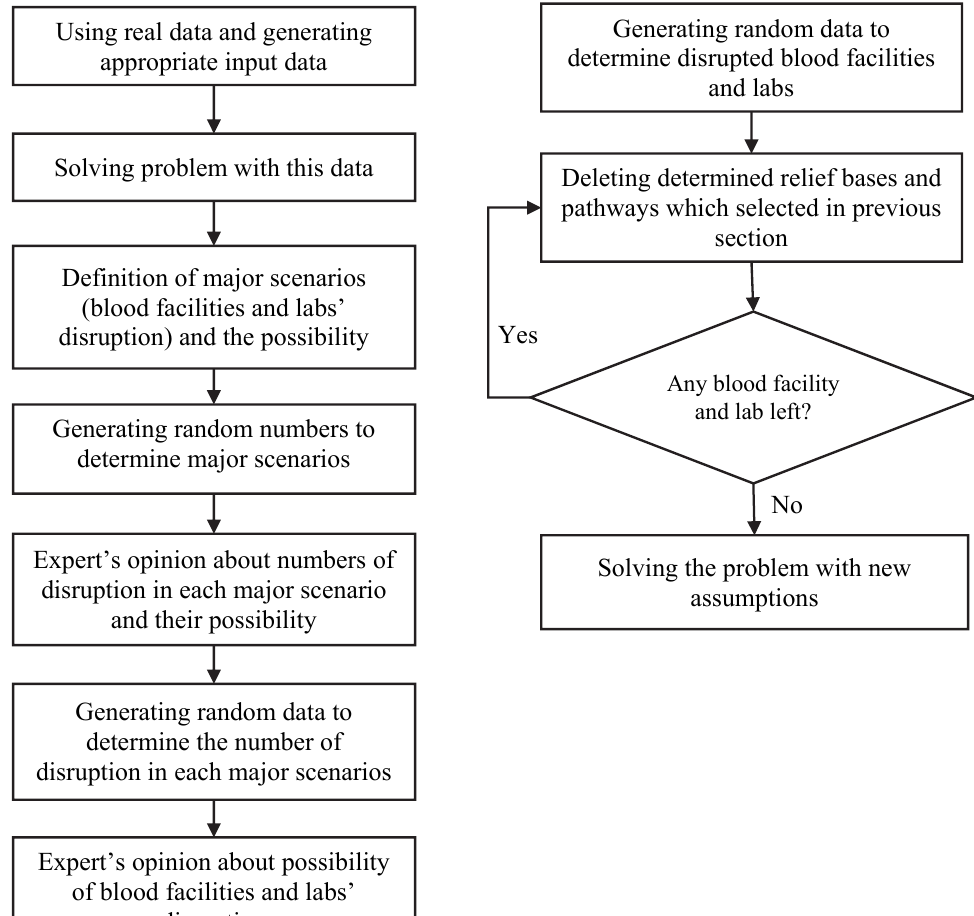
Fig. 2 Simulation flow chart to generate input